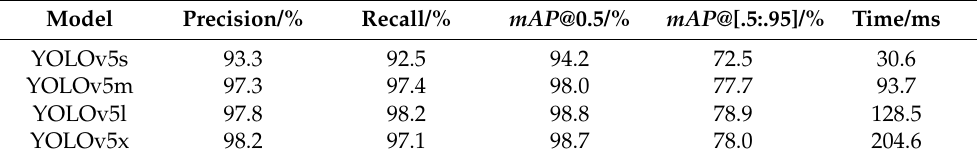
Table 3. Score of each model.